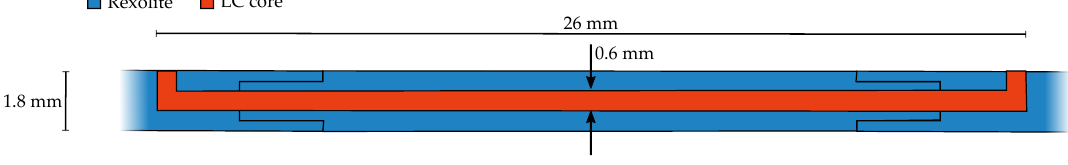
Figure 25. Measured (solid) and simulated (dashed) results of the step-index phase shifter. For simplification, s-parameter plots show perpendicular orientation only. Figure 26. Cross-section of the phase shifter designed as subwavelength fiber as presented in [43].